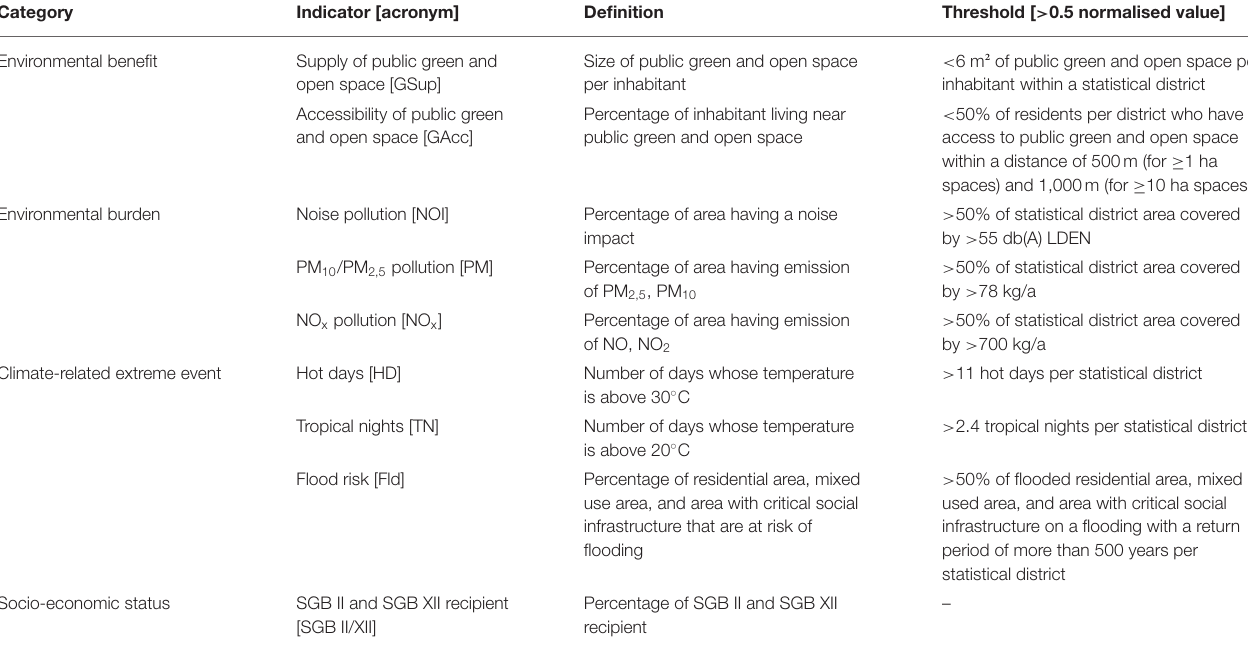
TABLE 1 | Indicators used for environmental justice